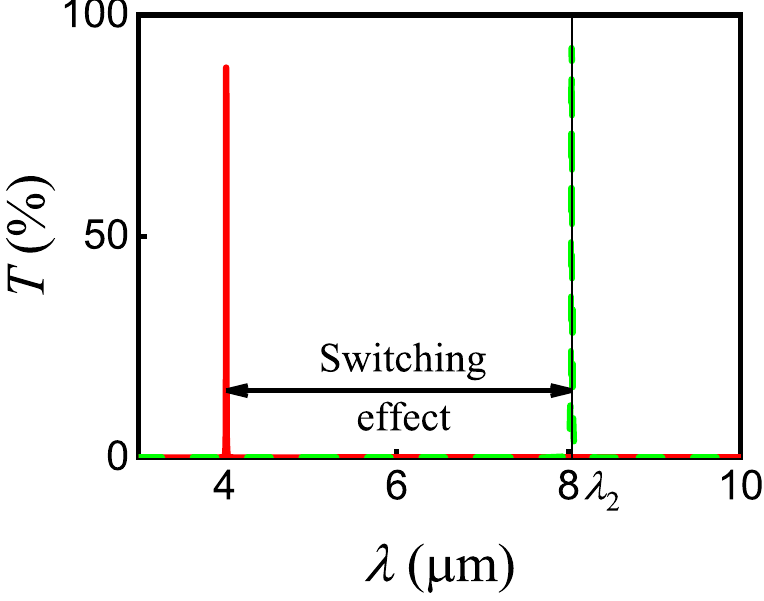
Figure 11. The signal SPP transmittance for the stub nanoresonator with InAs/ZnS NW in the vicinity of λ 2 in the absence (solid red line) and in the presence of pump SPP mode E 1 (dashed green